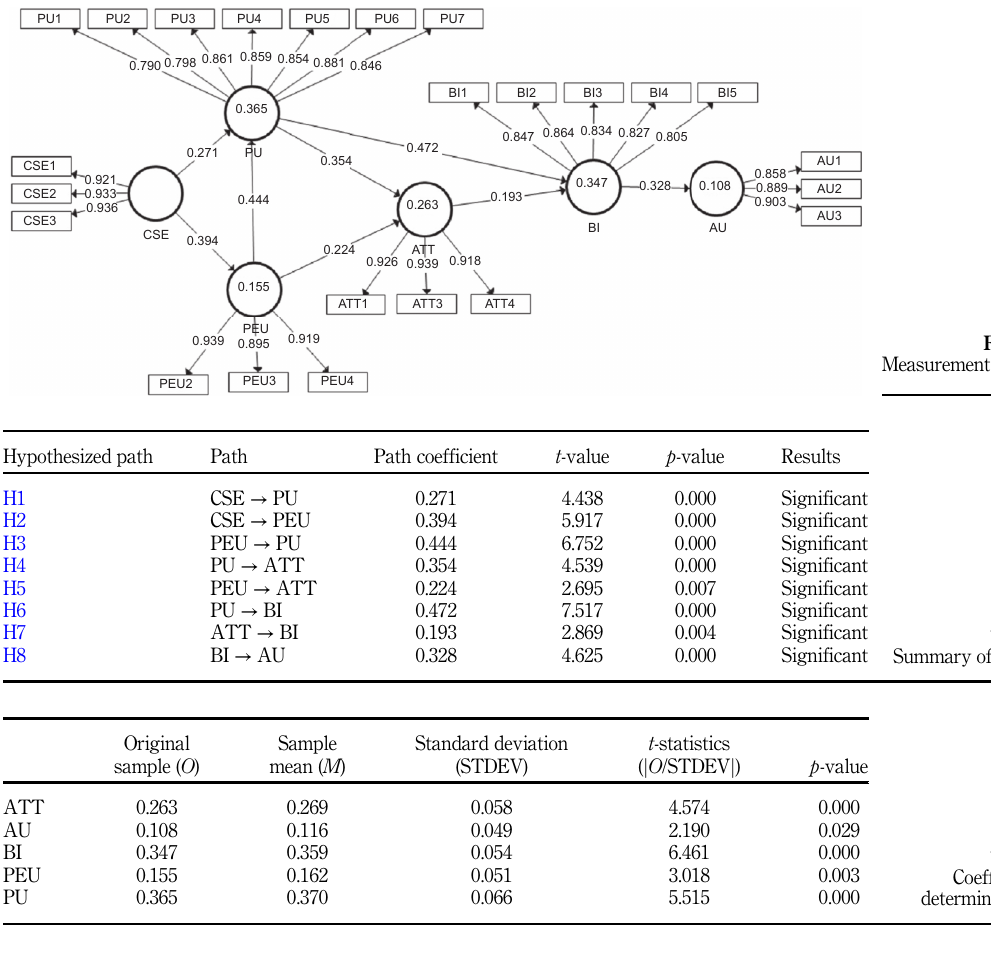
Table 6. Coefficients of